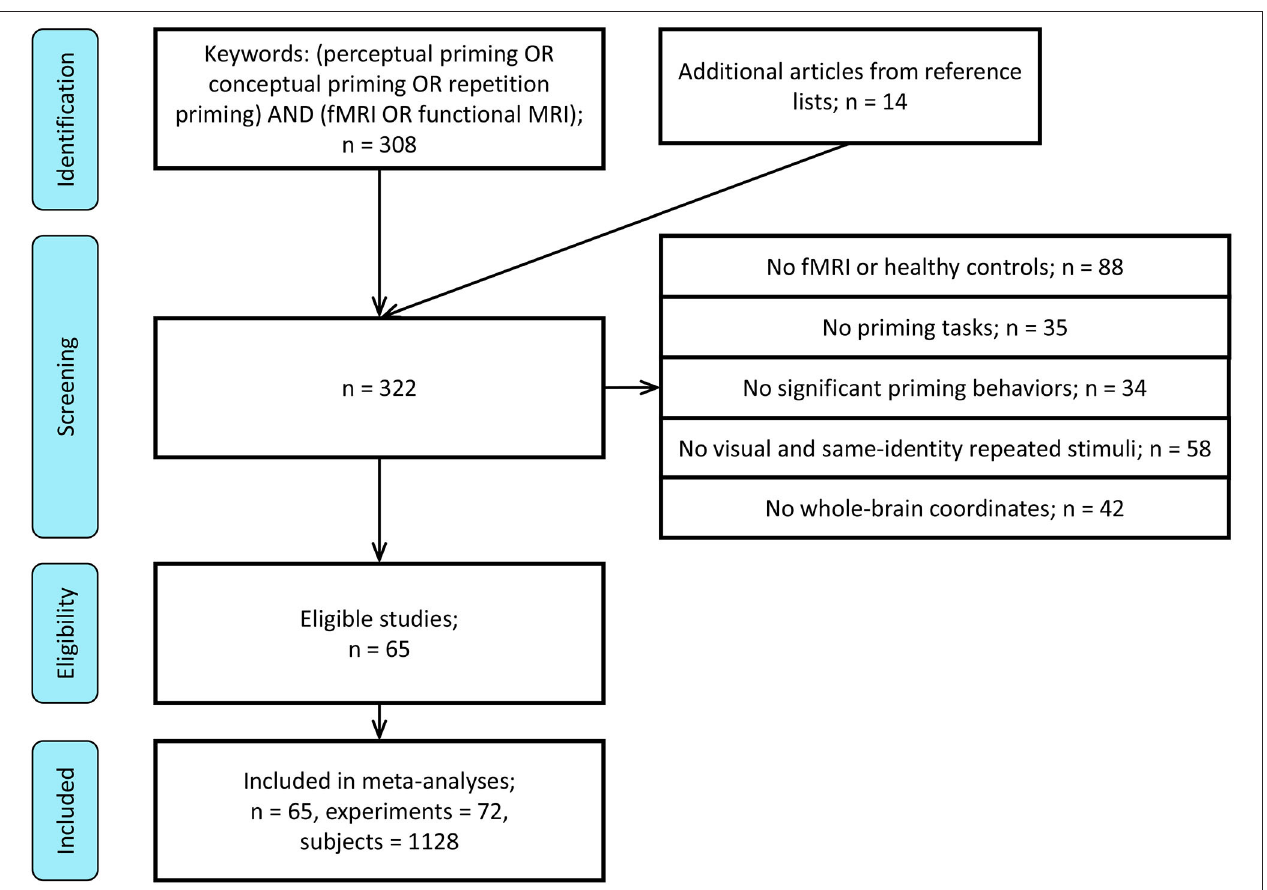
FIGURE 1 | PRISMA flow chart for procedure of study